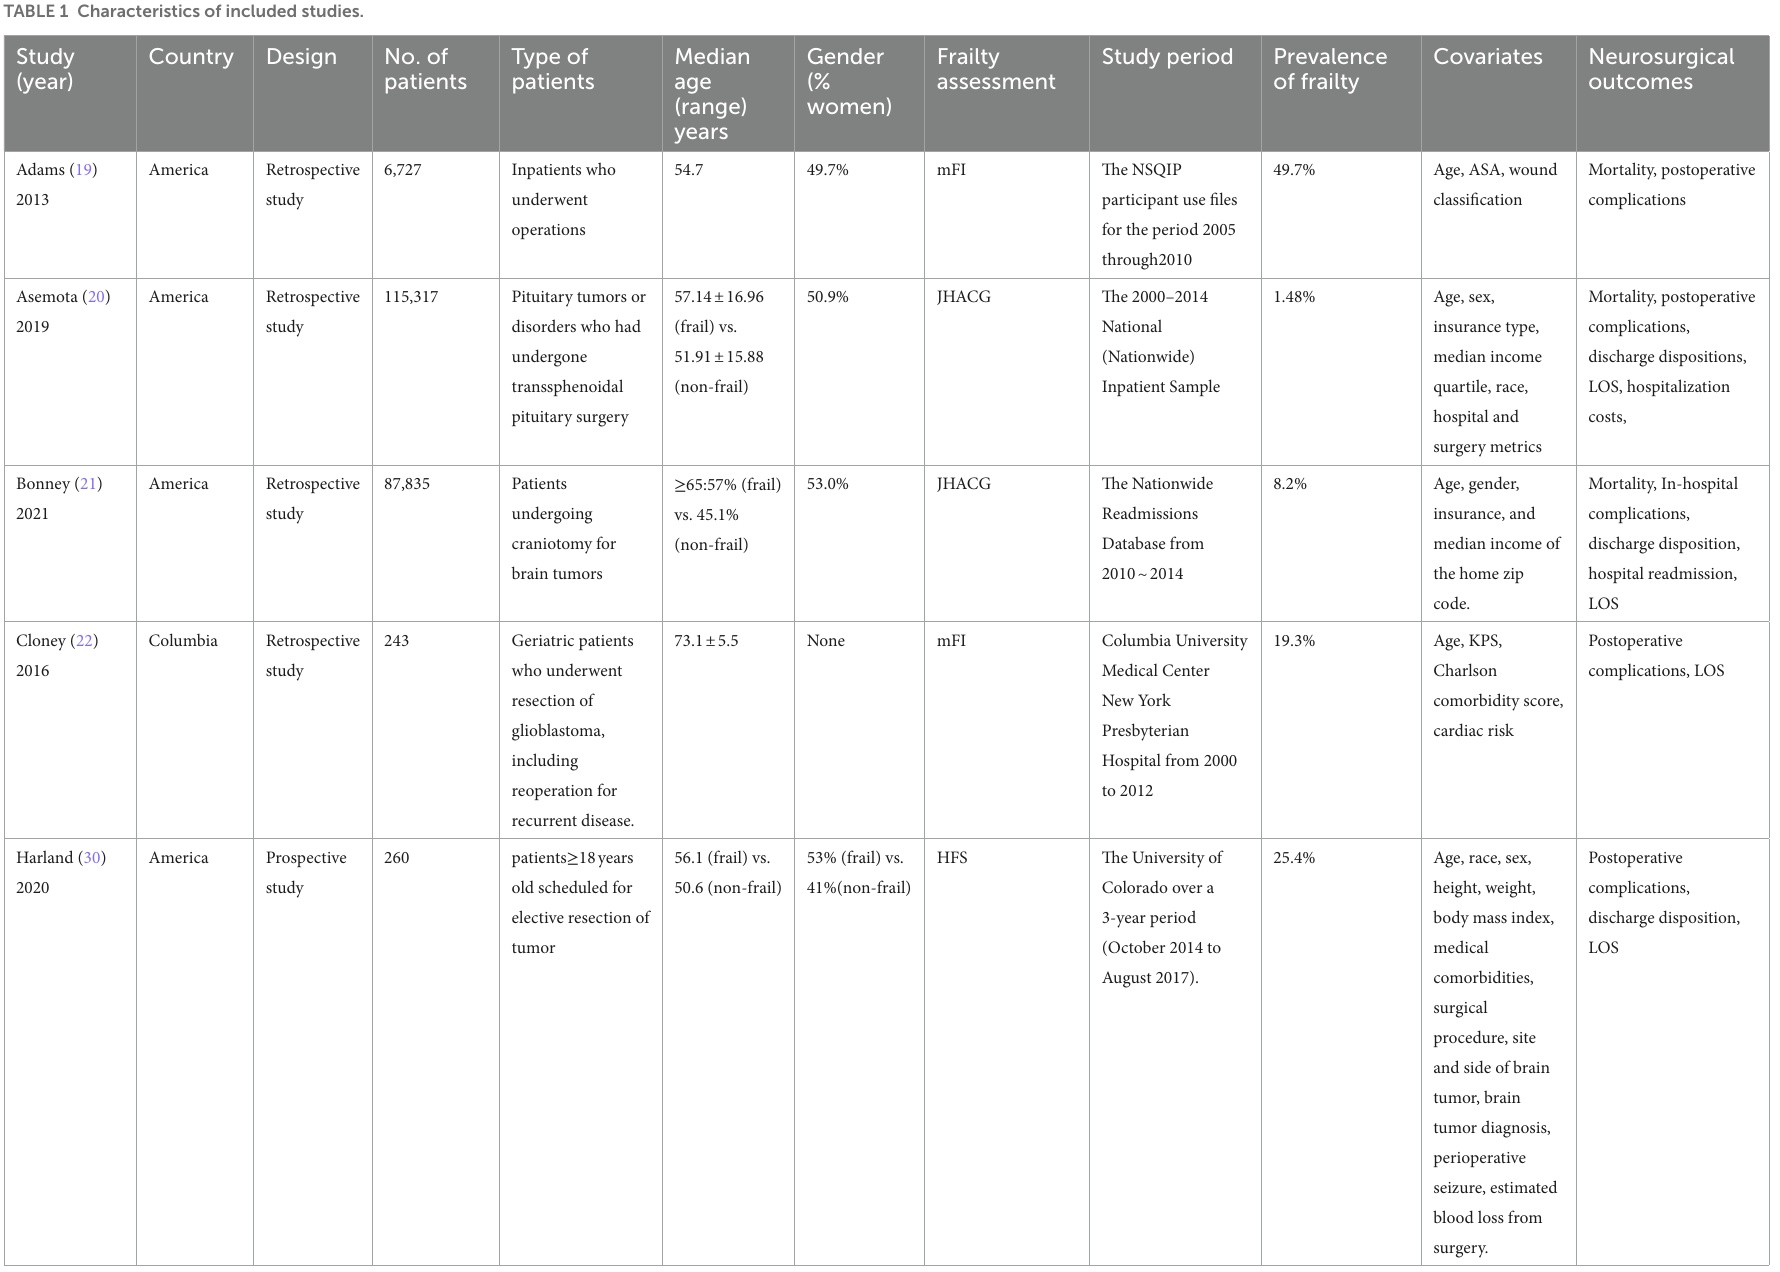
TABLE 1 Characteristics of included